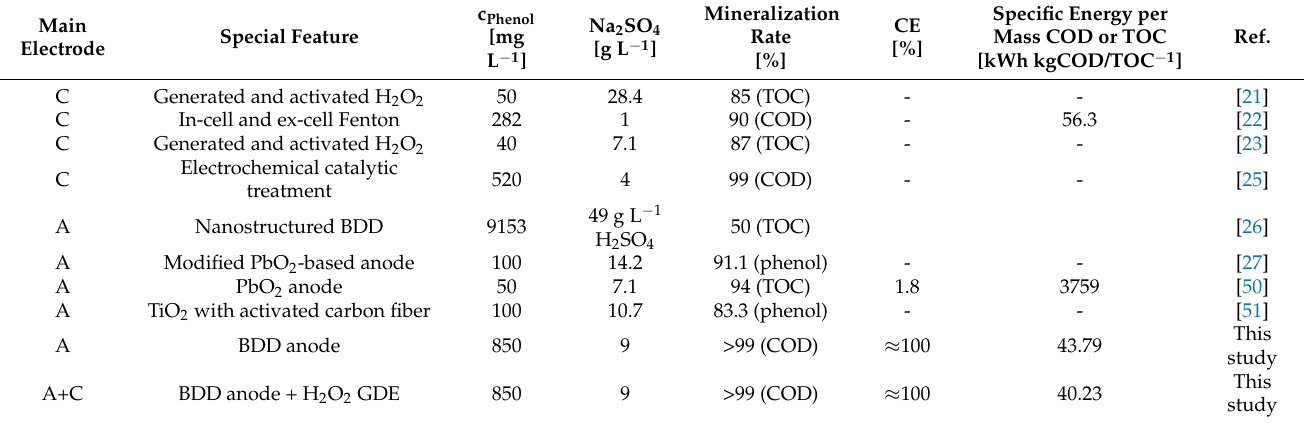
Table 3. Comparison of electrochemical phenolic degradation and specific energy consumption results from our study with those from the literature. The main working electrodes cited in the literature are denoted as “C” for cathode and “A” for anode, while details about the investigated electrolysis process are specified in the “special feature” column. Furthermore, c Phenol , CE, and TOC denote the concentration of phenols, current efficiency, and total organic carbon, respectively. Main